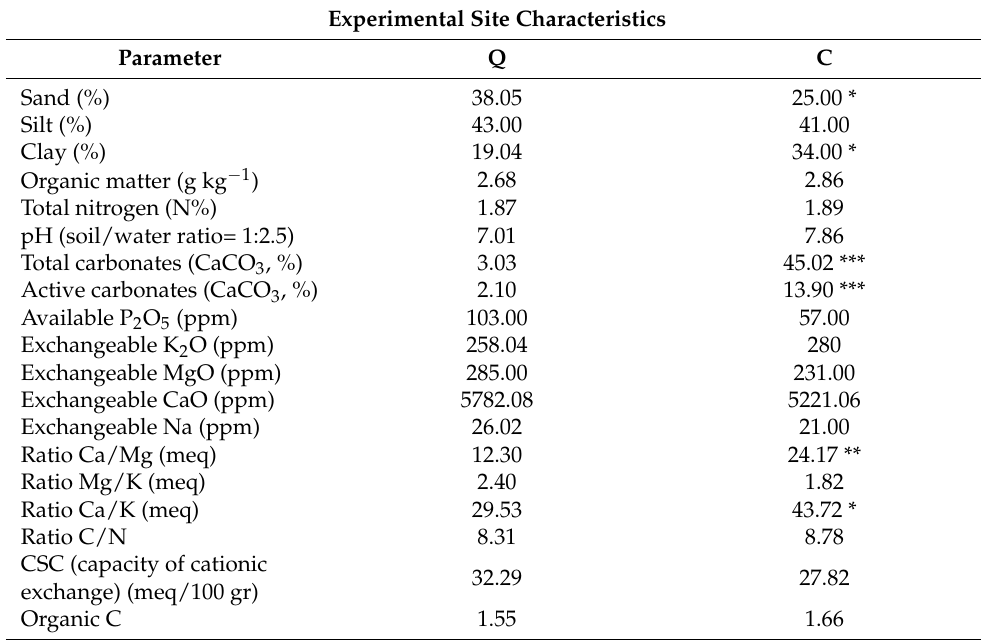
Table 1. Soil characteristics of the two experimental sites (C (Colombara) and Q (Quaiara)). Within rows, *; **; *** values are different at α ≤ 0.05, 0.01, and 0.001. Data are the mean of three replicates.